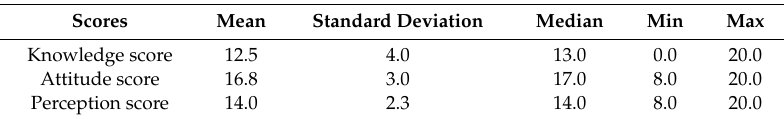
Table 2. Mean, standard deviation, median, minimum, and maximum for knowledge score, attitude score, and perception score.